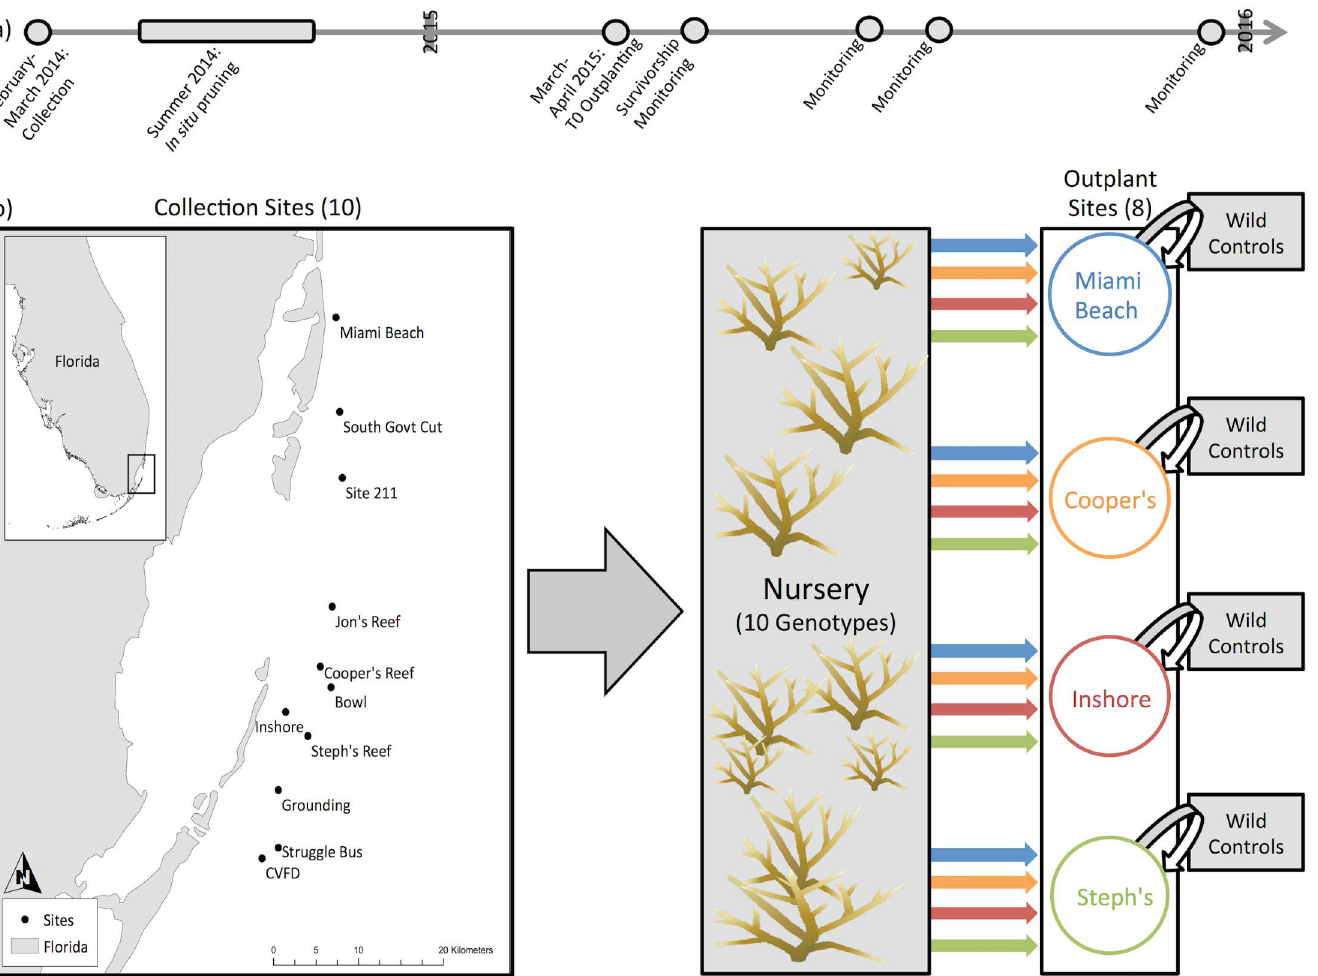
Fig 1. Experimental design and timeline. (a) Timelinefor collection,propagation, outplanting and monitoring.(b) Fragments were collectedfrom individual coloniesat each collectionsite (n = 10 sites/genotypes) and transportedto the nursery. After the nursery propagationphase, all genotypeswere taken to 8 of 10 originalcollectionsites (Government Cut, Site 211 excludedfor logisticalconstraints), so that each site received its originalcollection,plus 9 other genotypes from each other reef. At each outplantingsite, two colonieswere collectedas wild controls and installedin the plot with nursery transplants. Colors represent different genets coming from each reef, only 4 are presentedhere as an example.